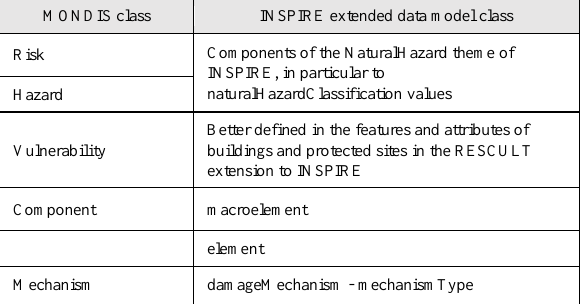
Table 1. Mapping between the MONDIS classes and INSPIRE extension classes.